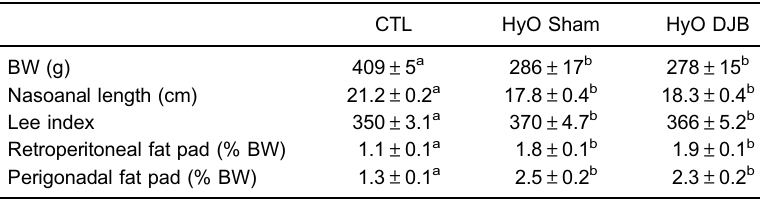
Table 1. Obesity parameters evaluated in control (CTL), hypothalamic obese (HyO) Sham and HyO with duodenal-jejunal bypass (DJB) rats.